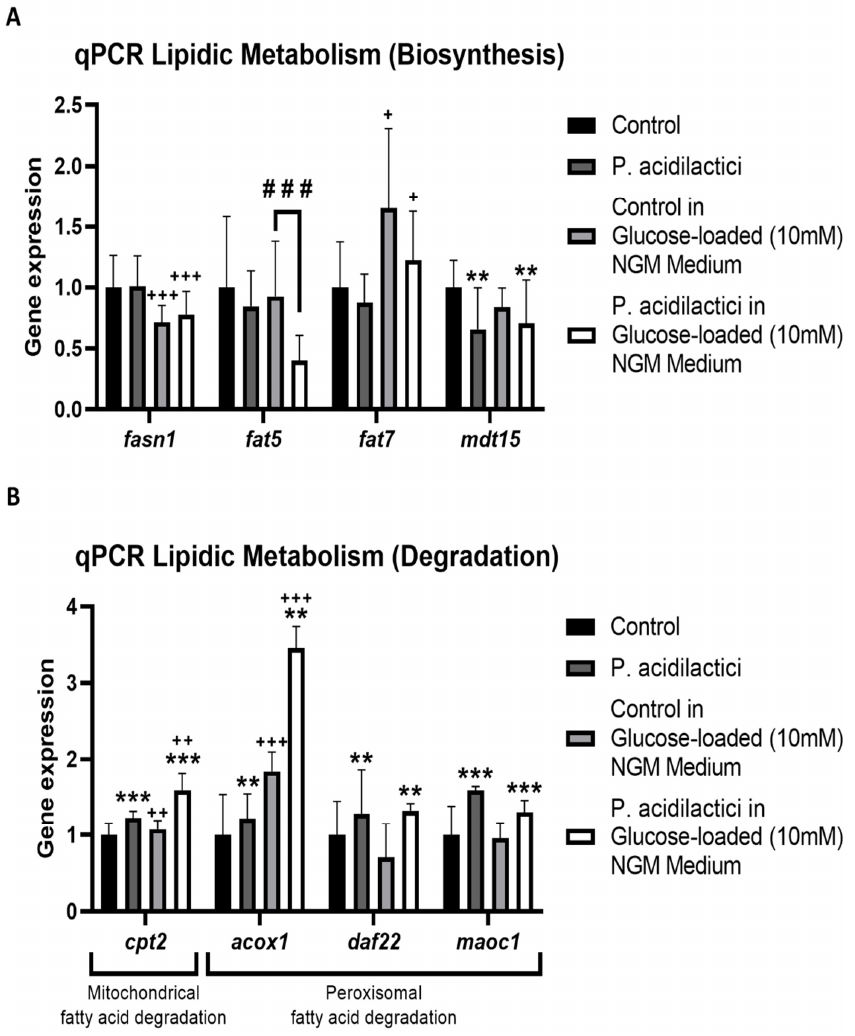
Figure 4. Gene expression analysis of key genes involved in the biosynthesis ( A ) and degradation ( B ) of lipids, quantified by real-time PCR (qPCR) in C. elegans . Gene expression levels were normalized to the housekeeping gene ( pmp-3 ). Data are expressed using the 2 − ∆∆ Ct method. A two-way ANOVA (main effects: pA1c, glucose and their interaction), followed by a Student’s t-Test was carried out to evaluate statistical differences between groups: Two-way ANOVA results when pA1c factor is significant: ** p < 0.01, *** p < 0.001. Two-way ANOVA results when glucose factor is significant: + p < 0.05, ++ p < 0.01, +++ p < 0.001; Student’s t -Test when interaction between factors is significant: ### p < 0.001 vs. control in a glucose-loaded NGM